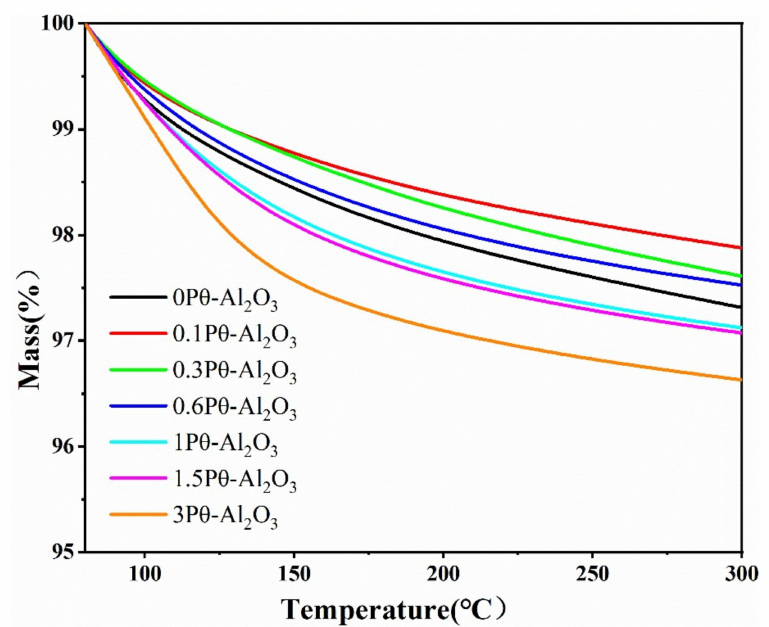
Figure 1. The weight loss curves of supports measured by